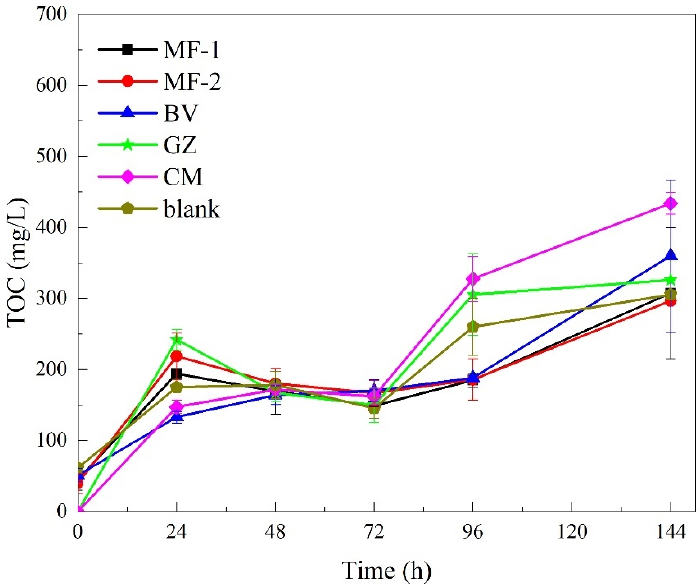
Figure 2. TOC during V(V) removal processes by straw and various fillers (Group MF-1, MF-2, BV, GZ, CM and blank).